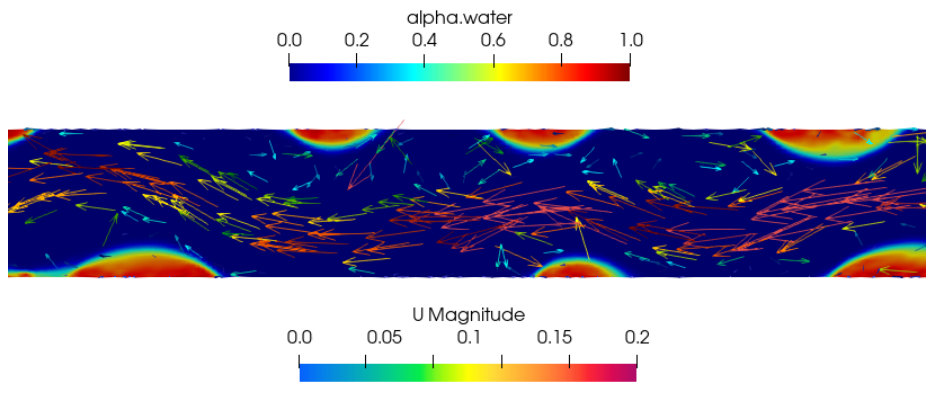
Figure 24. Distribution of velocity vector along the pipe with turbulent flow in the Xu model, speed expressed in m/s.